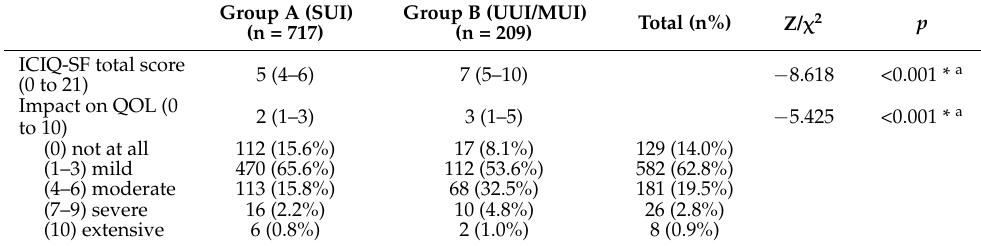
Table 4. Severity and impact of UI on QOL in elderly women.